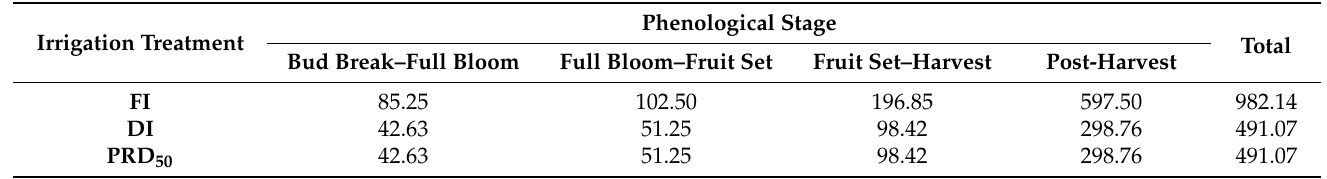
Figure 2. Ten-day reference evapotranspiration (ET 0 , red line) and crop evapotranspiration (ETc, green line) values during 2016. Table 1. Applied irrigation water quantity (mm) by phenological stage and irrigation treatment of Flordastar peach tree.